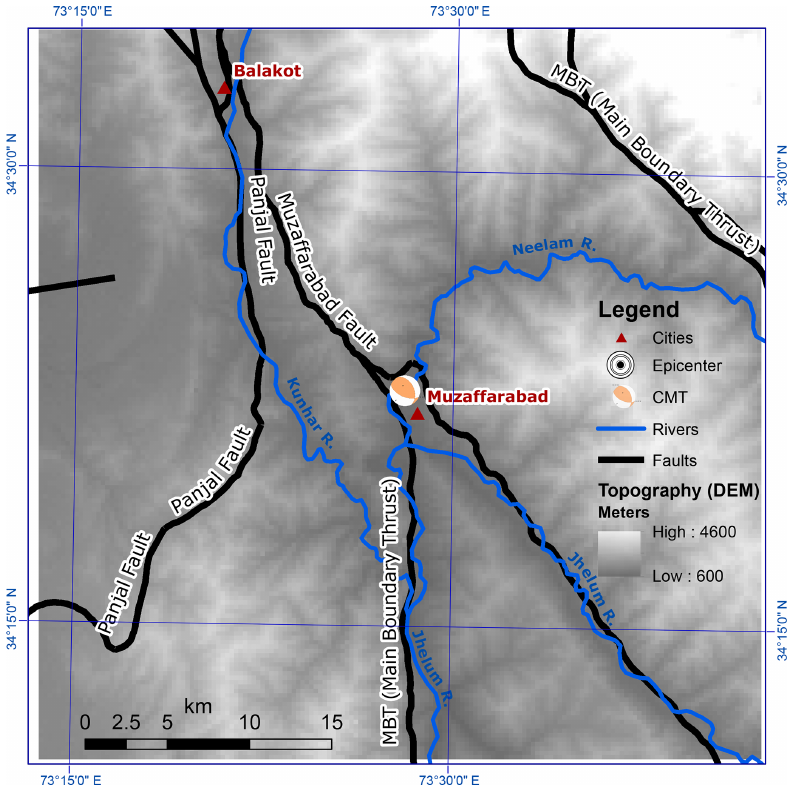
Figure 1. Digital elevation model (DEM) of the study area of Muzaffarabad (Pakistan). The Main Boundary Thrust (MBT) and its segments (after Hussain et al., 2009) are shown along with centroid moment tensor (CMT)